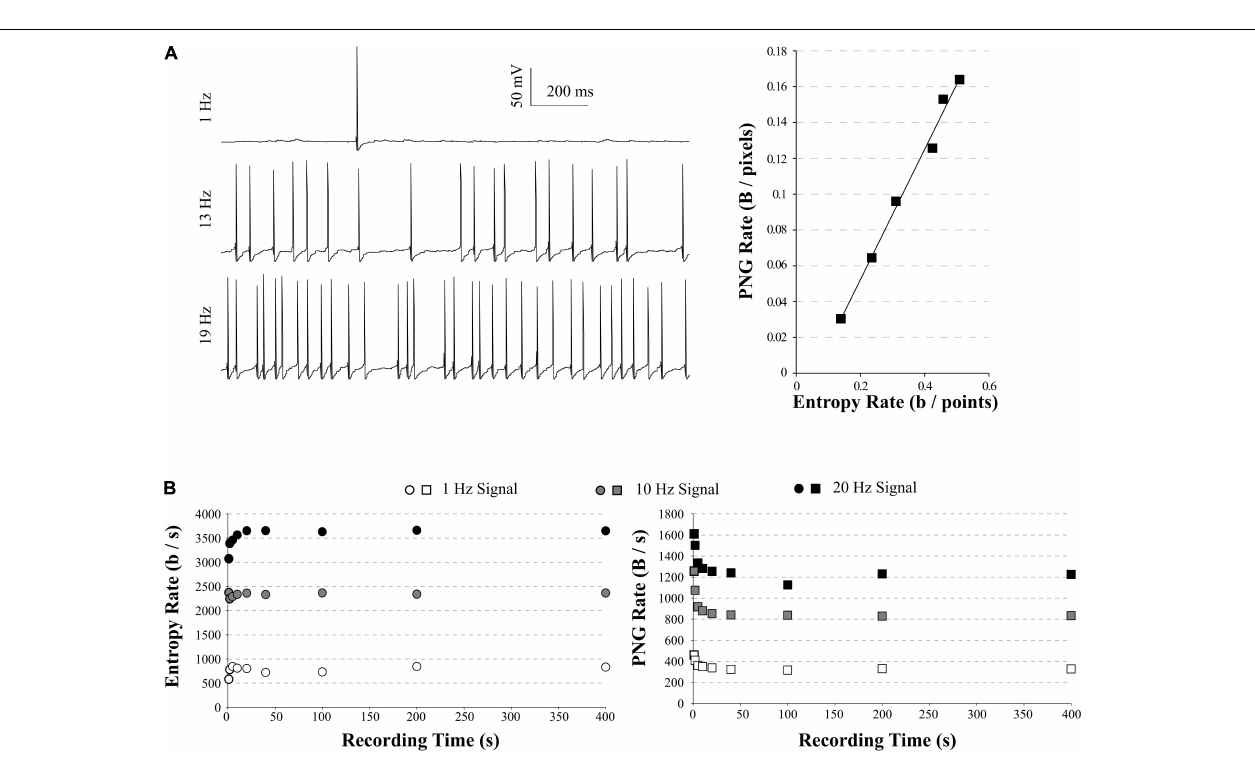
FIGURE 3 | PNG Rate on a model of neuronal activity. (A) Left: example of traces obtained with our model, increasing the number of synapses to obtain spiking activity from 1 Hz (top) to 20 Hz (bottom). Right: The PNG Rate (Bytes/pixels) is linear to Entropy Rate (bits/points), following y 0 . 36 x − 0 . 02 ( R 2 = 0.99). (B) Impact of the simulation duration on the Entropy Rate (Left) and PNG Rate (Right). Entropy Rate converges toward a stable solution in around 5 s of recordings, or 1 sweep. The PNG Rate needs around 40 s to obtain a stable value. As the PNG algorithm starts by linearizing the data, this is equivalent to 8 sweeps of 5 s each.